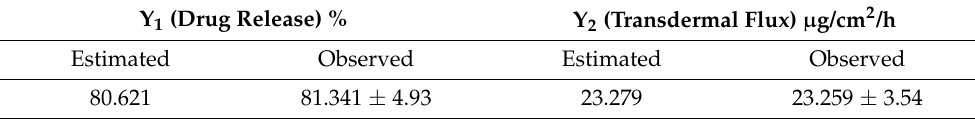
Figure 7. Overlay plot of the optimized drug in the adhesive patch using design space. Table 5. Estimated and observed values of dependent variables of the optimized